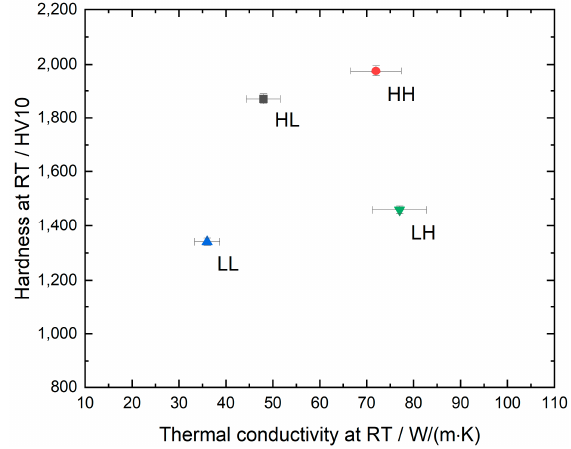
Figure 2. Thermal conductivity and hardness at room temperature.